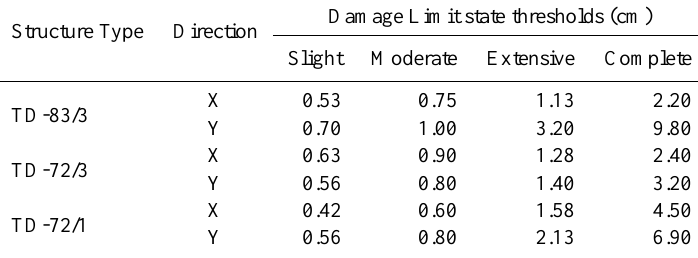
Table 3. Damage limit states according to Lagomarsino and Penna (2003).